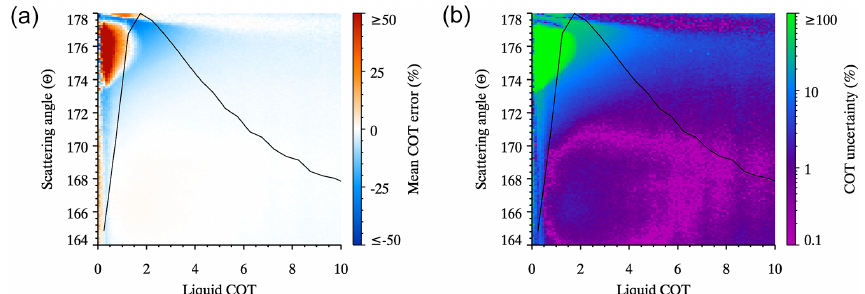
Figure 10. A magnified view of the mean single-channel COT retrieval error (a) and uncertainty (b) corresponding to the liquid phase plots in Fig. 9, here for COT<10. Black lines again denote the COT retrieval PDFs. Table 1. Liquid and ice phase COT retrieval statistics using different cloud thermodynamic phase algorithms. Cloud phase COT mean COT median COT standard deviation Liquid Ice